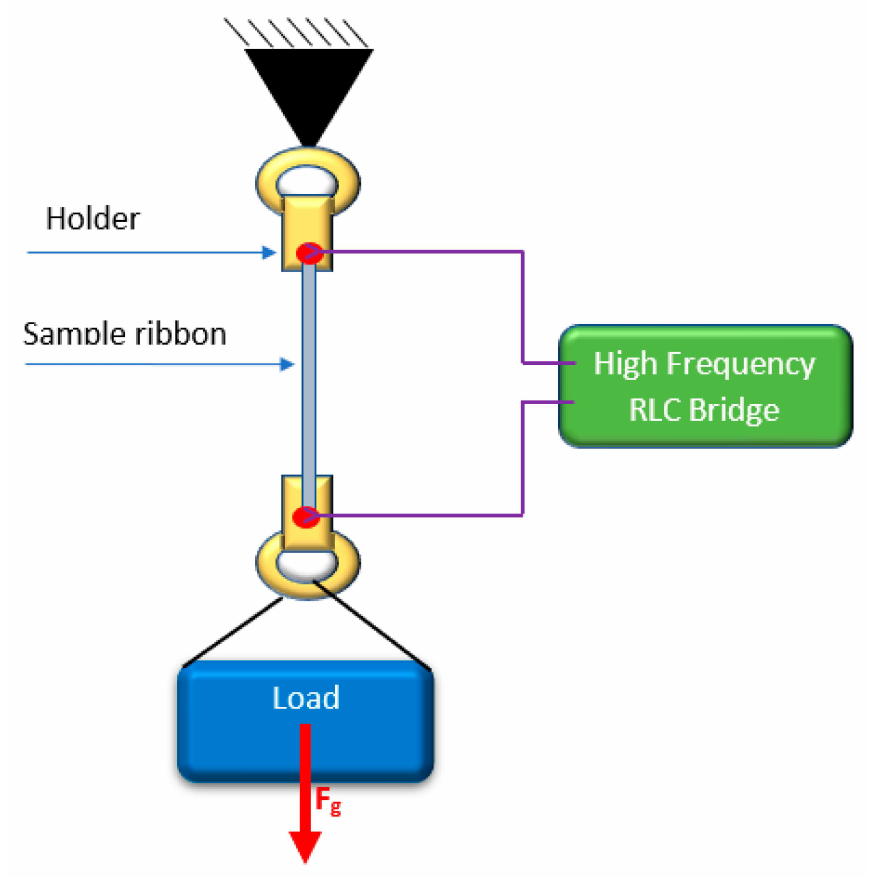
Figure 1. Schematic diagram of the developed SI measurement